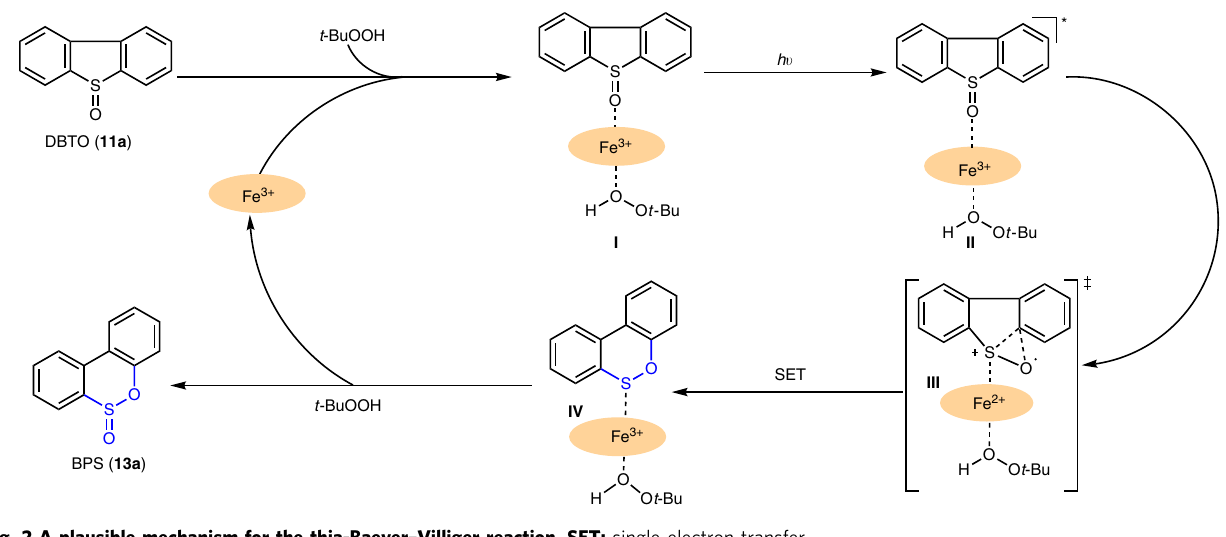
Fig. 2 A plausible mechanism for the thia-Baeyer – Villiger reaction. SET: single-electron